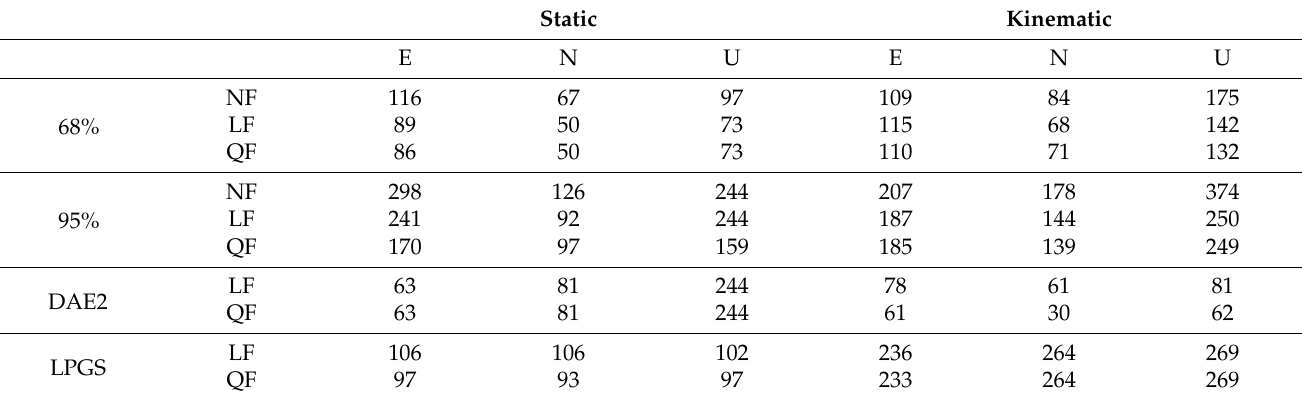
Table 2. Convergence times of the NF model, LF model, and the QF model in combination R (unit: min). Static